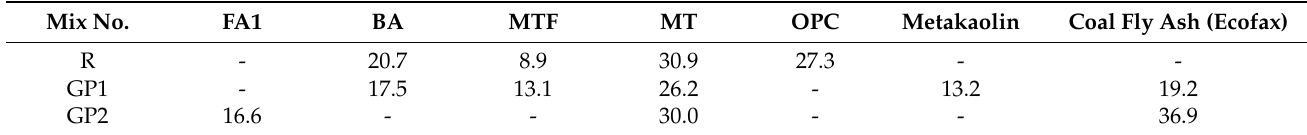
Table 2. Mixture design used in the preparation of the composites; values expressed in wt.%. Mix